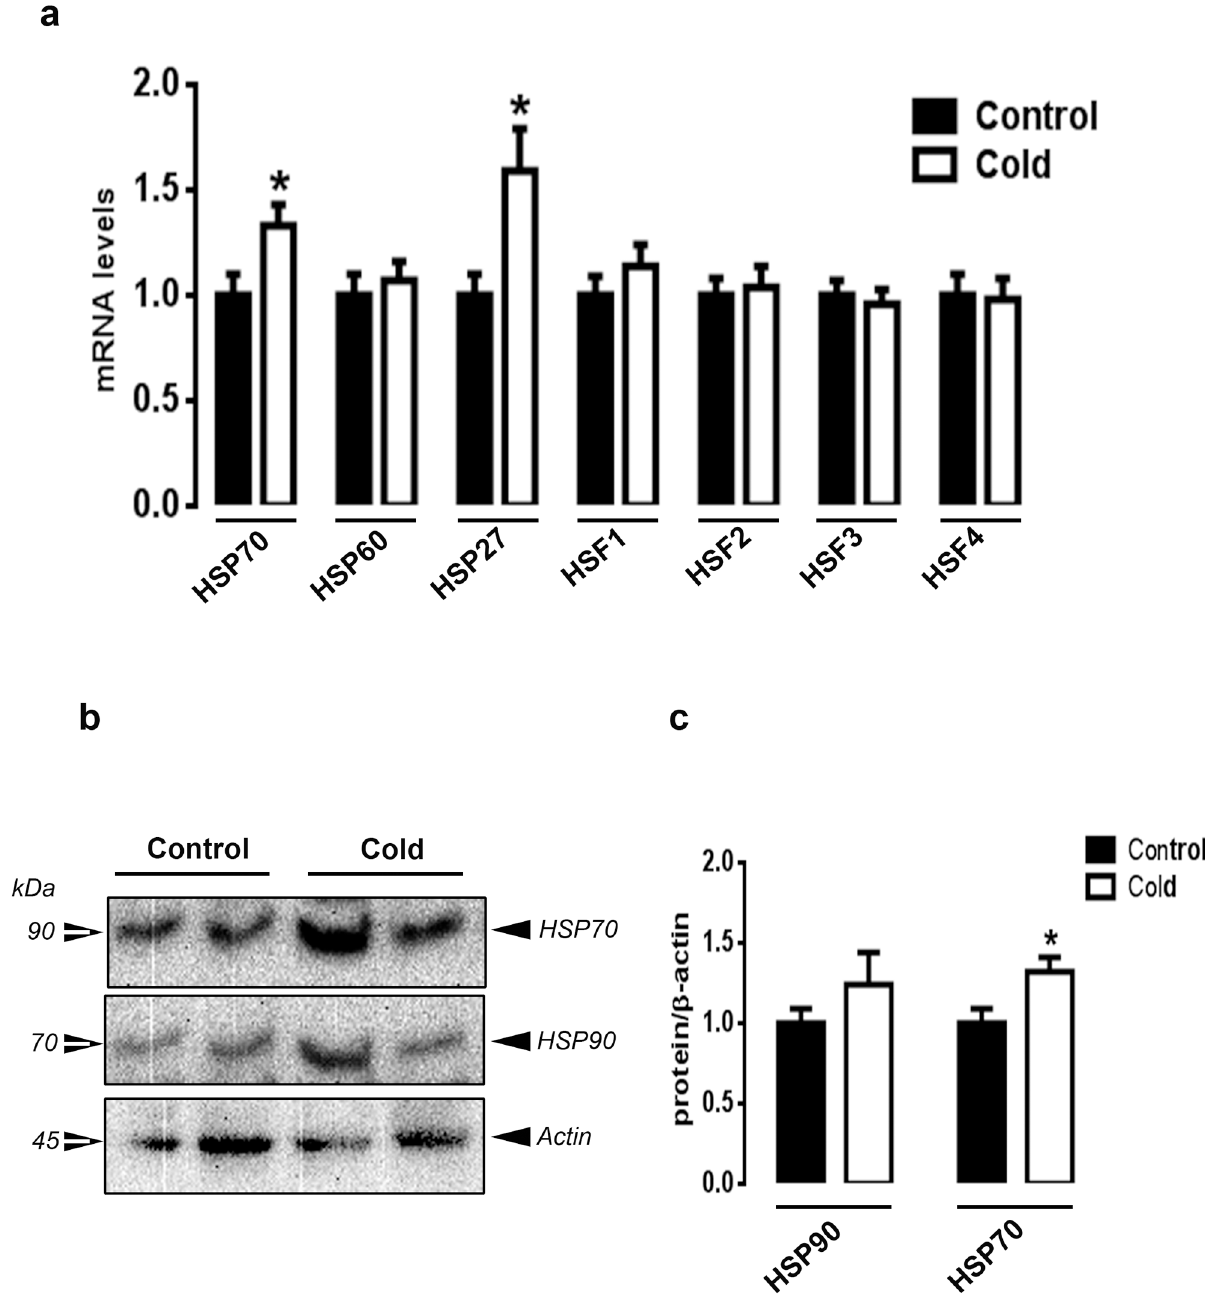
Fig 5. Effect of CMCC on HSP and HSF expression in liver of young broiler chicks. HSP and HSF mRNA levels were measured by qPCR (a). HSP70 and HSP90 protein levels were determined by Western blot (b) and presented as normalized ratio to β -actin (c). The values represent the mean ± SEM (n = 6). * Indicates a significant difference between cold and control group ( P <